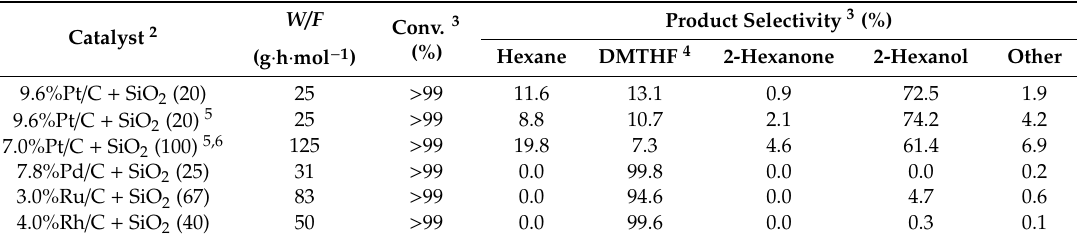
Table 1. Hydroconversion of 2,5-dimethylfuran over noble metal catalysts 1 .